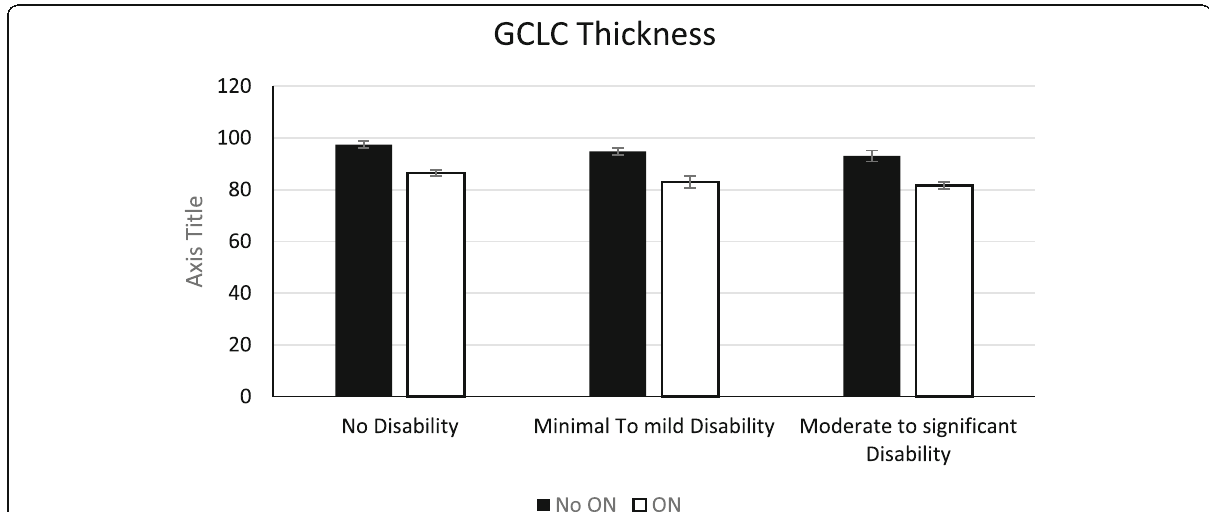
Fig. 4 Mean ganglion cell layer complex (GCLC) thickness in the 3 patient groups with history of optic neuritis (ON) and without history of optic neuritis (No